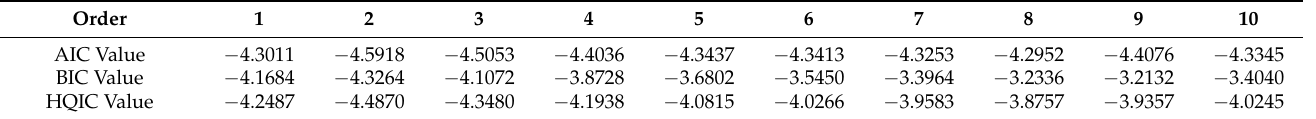
Table 3. The AIC BIC, and HQIC values of the integrated autoregressive model with order one to ten.